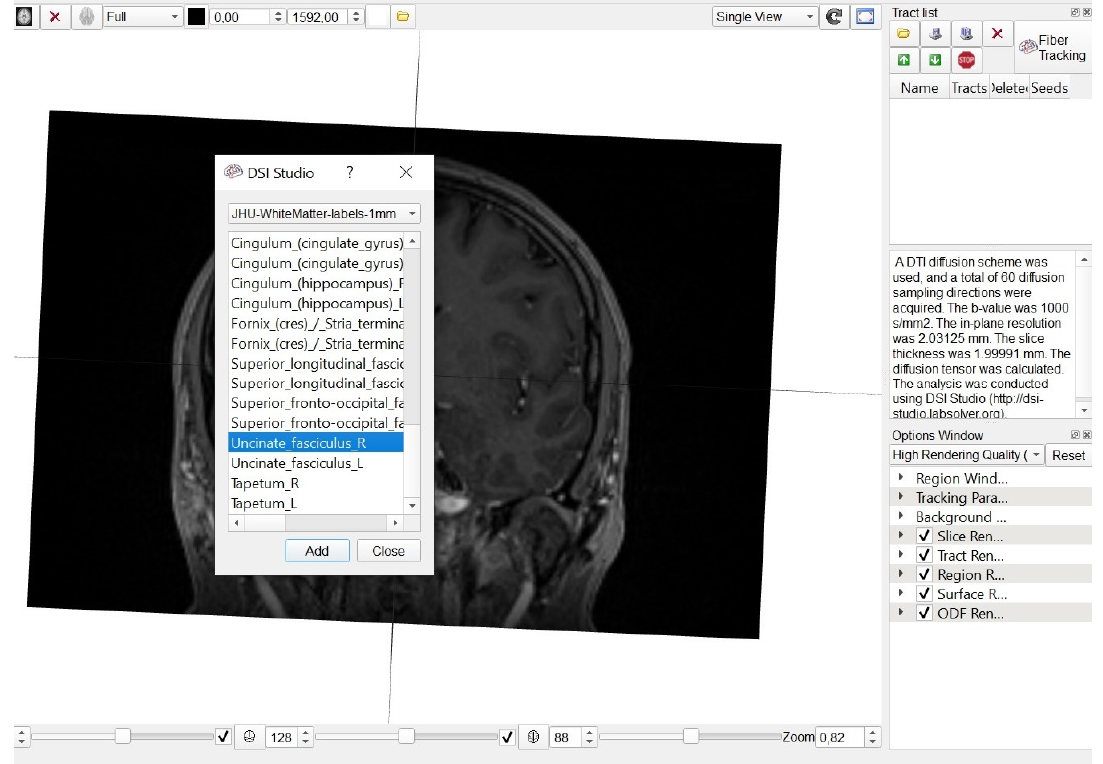
Figure 1. Anatomical atlas loaded in to the DSI studio software.